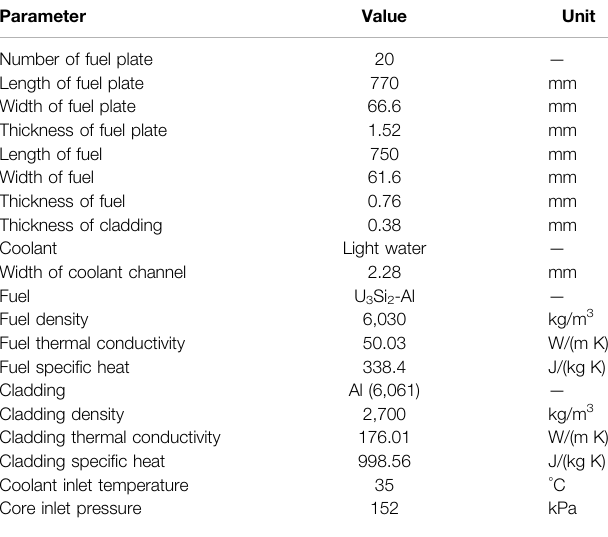
TABLE 1 | Parameters of the research reactor fuel